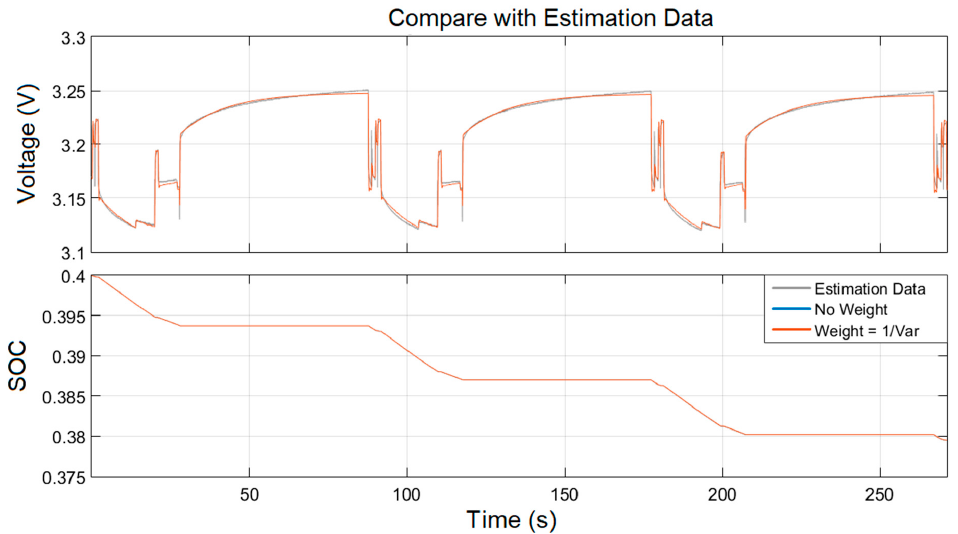
Figure 5. Comparison of the two outputs of the nonlinear grey box model estimation data with the best experiment.